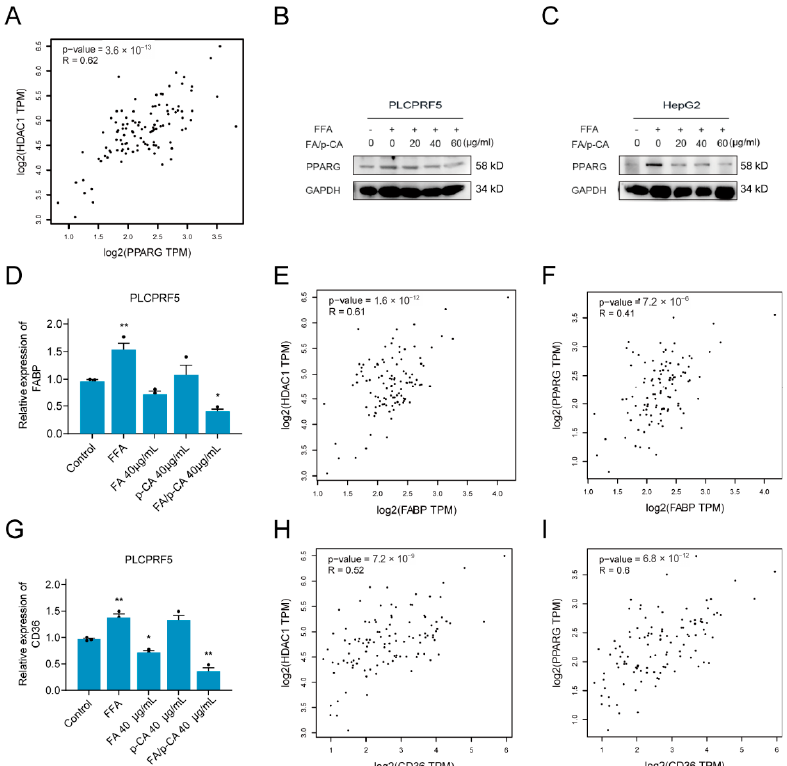
Figure 6. FA/p-CA inhibit hepatic lipid uptake via the HDAC1/PPARG axis. ( A ) The correlation analysis between HDAC1 and PPARG. ( B , C ) The PLCPRF5 ( B ) and HepG2 ( C ) cells were, respectively, exposed to increasing concentrations of FA, p-CA, and FA/p-CA, and then the expression of PPARG was determined by Western blot. ( D ) The PLCPRF5 cells were, respectively, exposed to FA, p-CA, and FA/p-CA, and then the expression of FABP was determined by qRT-PCR. Data represented as mean ± SD. ( E , F ) The correlation analysis between FABP and HDAC1 ( E ) or PPARG ( F ). ( G ) The PLCPRF5 cells were, respectively, exposed to FA, p-CA, and FA/p-CA, and then the expression of CD36 was determined by qRT-PCR. Data represented as mean ± SD. Compared to control, * p < 0.05, ** p < 0.01. ( H , I ) The correlation analysis between CD36 and HDAC1 (N) or PPARG